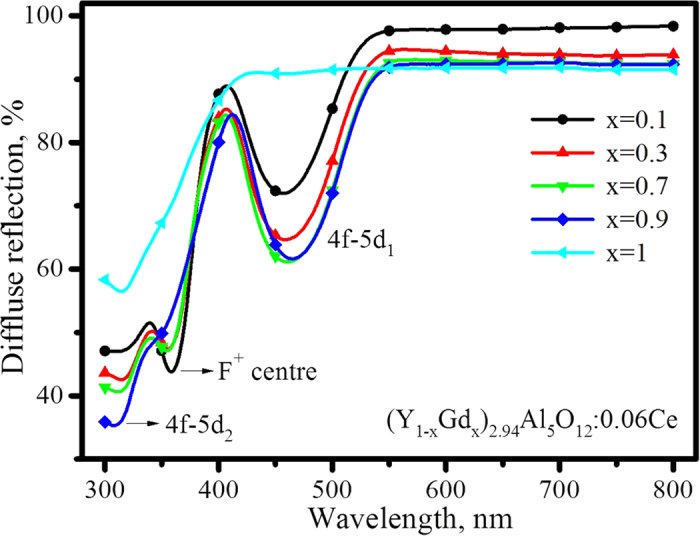
Diffuse reflection spectra of (Y1−xGdx)2.94Al5O12: 0.06Ce3+.